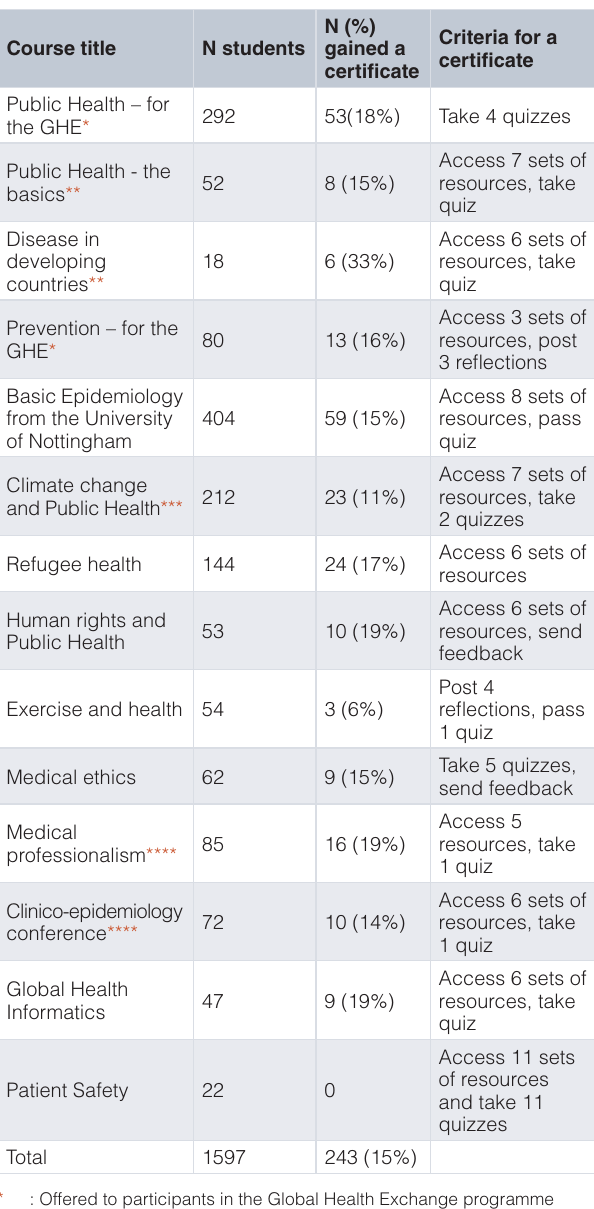
Table 1. Numbers of students enrolled in each course, and the number of students who gained a certificate. The criteria for a certificate are also shown.